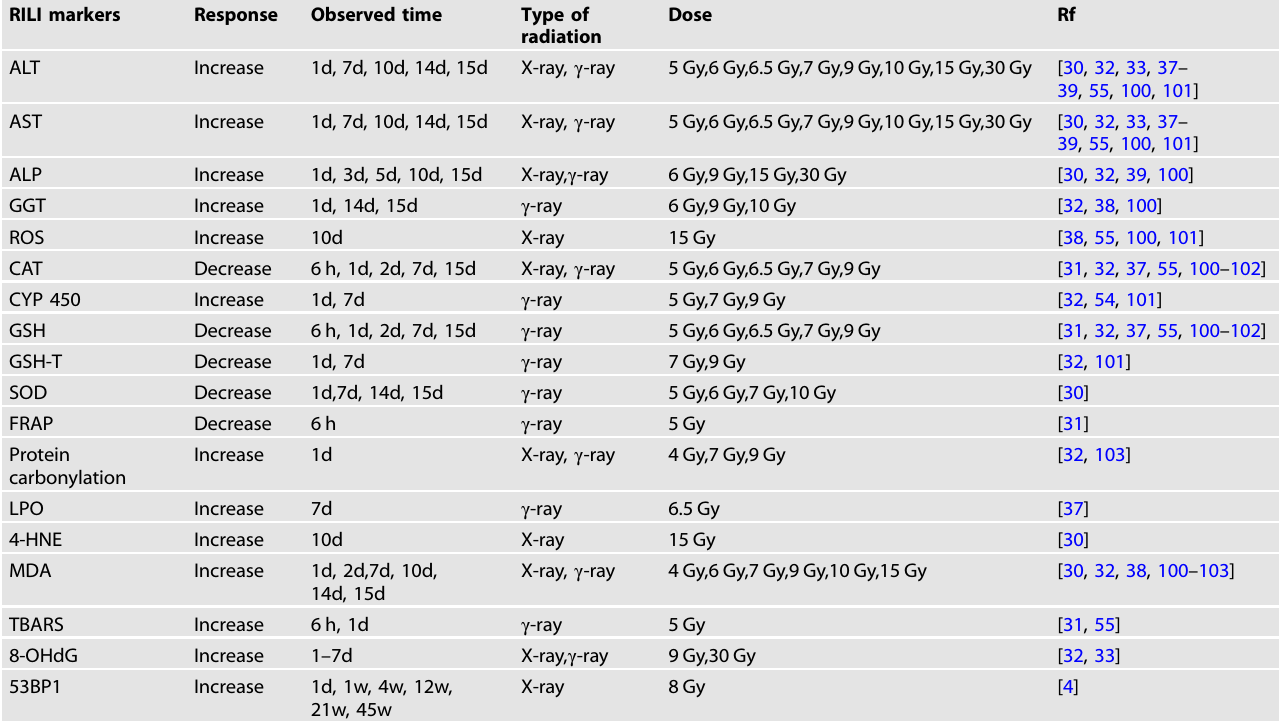
Table 1. RILI markers observed after radiation exposure.